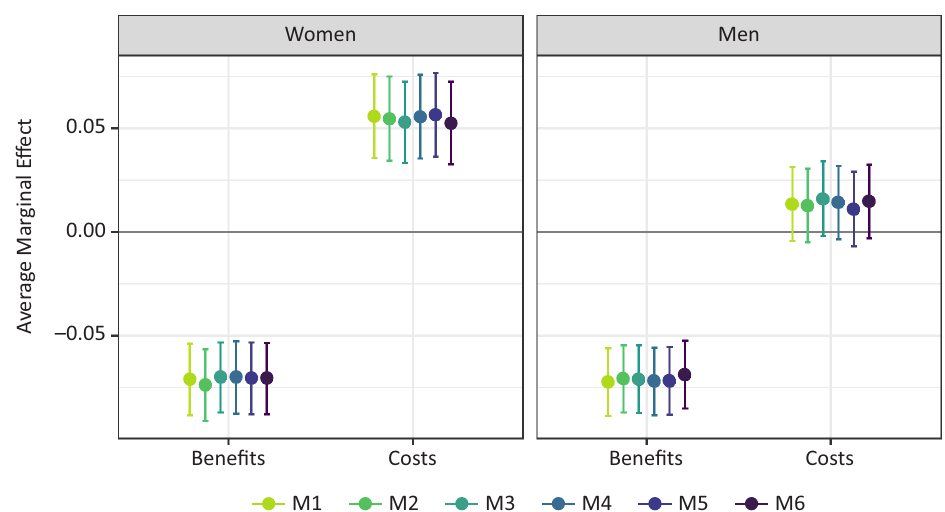
Figure 3. Effects of perceived costs and benefits of having children on intention to remain childless. Notes: Average marginal effects (AMEs) of intending to remain childless (vs. reference category: intending children in the future) in models M1–M6 together with 95% confidence intervals; AMEs expressed on the scale of the response variable (as changes in probabilities) from logistic models M1–M6 estimated jointly for women and men. AMEs express a change in the probability in response to an increase by one standard deviation.